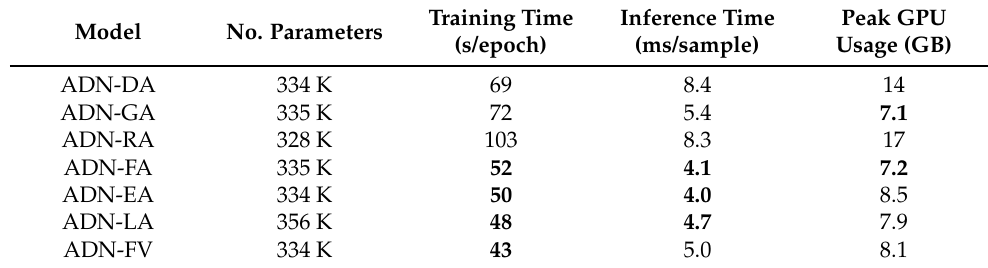
Table 3. Time and resource utilization of different attention types for ADN on